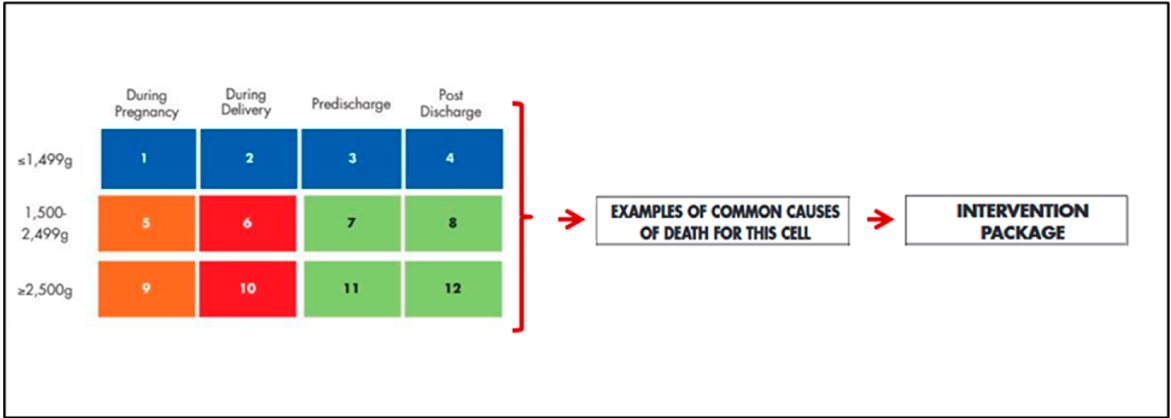
Figure 1. World Health Organization B.A.B.I.E.S. Matrix tool, modified from Joy Lawn et al.